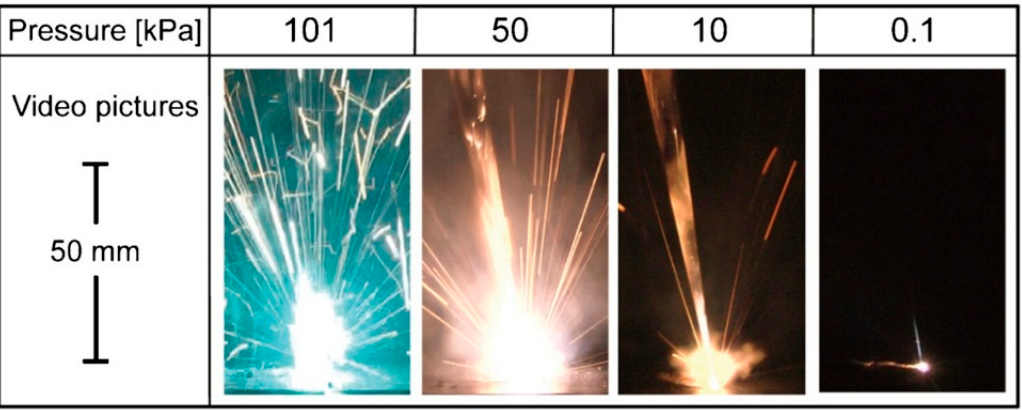
Figure 6. Typical video pictures of A5052 aluminum alloy laser induced plume observed under each reduced pressure (laser power is 16 kW, welding speed is 1 m/min, defocus distance is 0 mm). Reproduced with permission from [44], Taylor & Francis, 2014.